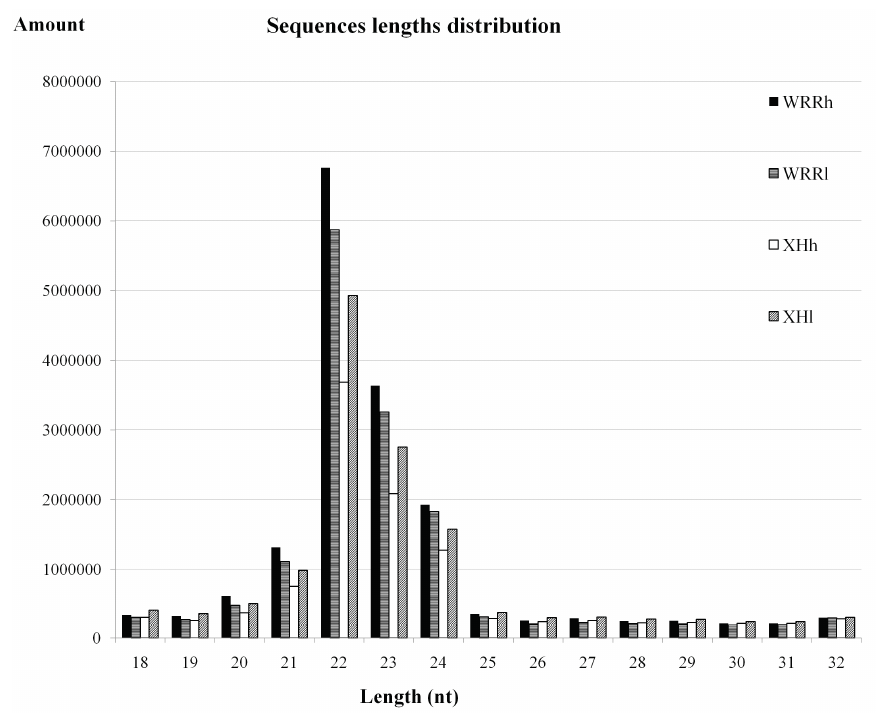
Figure 1. Length distribution and abundance of small RNAs sequences in chicken breast tissue. Clean reads of 18–32 nt for all four groups were assessed for size distribution; and the most abundant size class was 22 nt; followed by 23 and 24